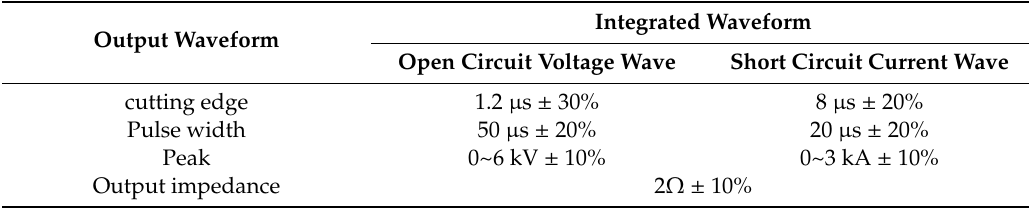
Table 3. Main parameters of lightning surge generator (LSG-510A).